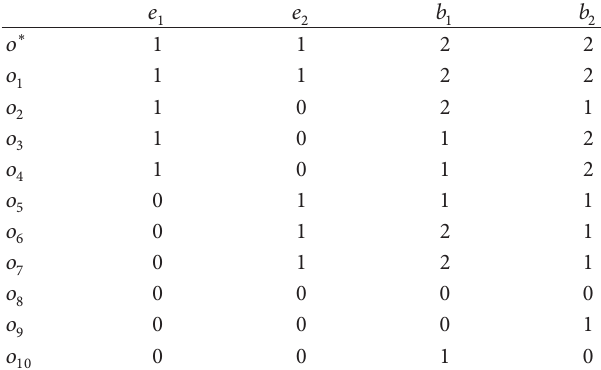
Table 2: Function 𝜌 in behavioral information